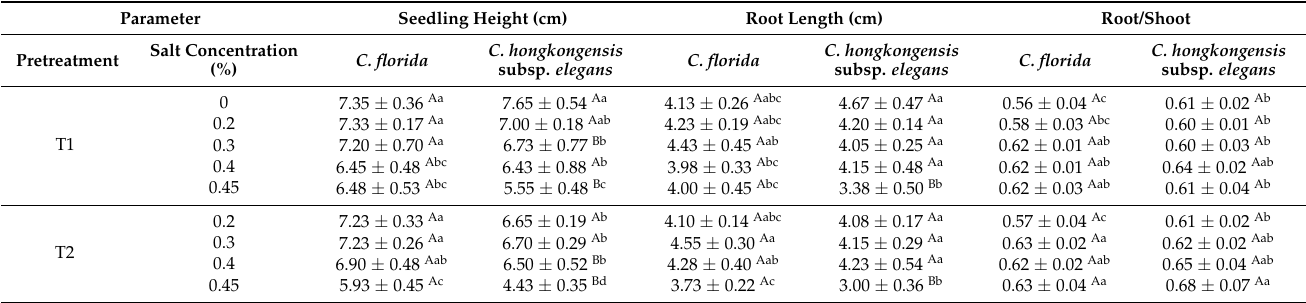
Table 2. Effects of different treatments on seedling height, root length, and root/shoot ratio of C. florida and C. hongkongensis subsp. elegans. Values are means of 3 independent replicates ± standard error. Different uppercase letters indicate the significant difference between species in the same treatment, and different lowercase letters indicate the significant difference among treatments for the same species according to Duncan’s new multiple range test ( p < 0.05), similarly for Table 3.